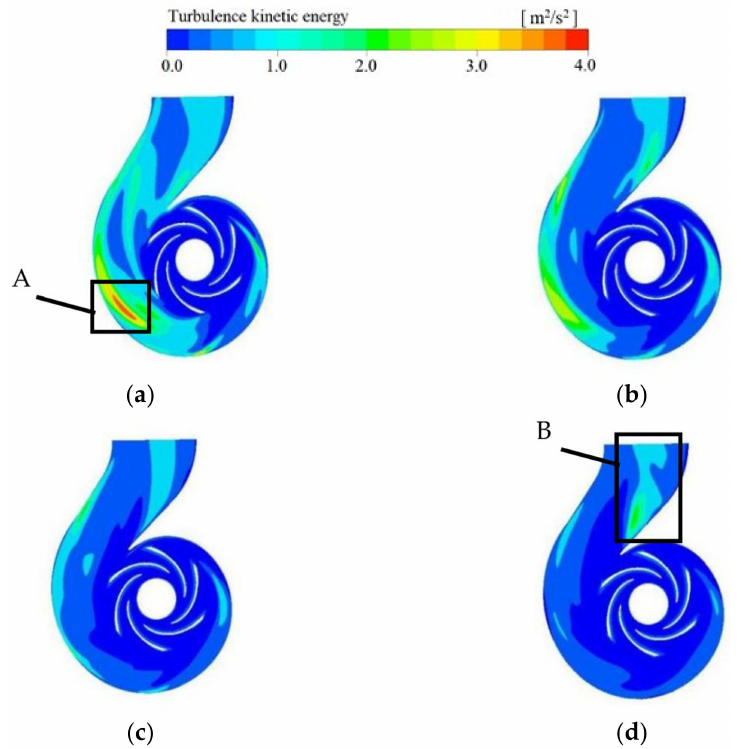
Figure 9. Turbulence kinetic energy in pump cross-section at different flow rates: ( a ) 800 m 3